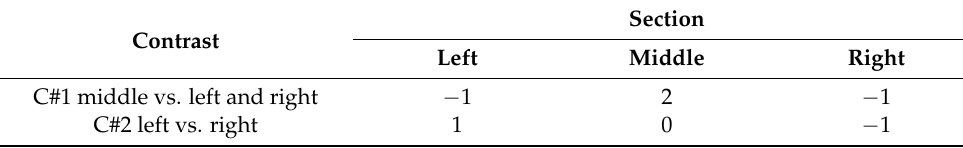
Table 2. Set of orthogonal